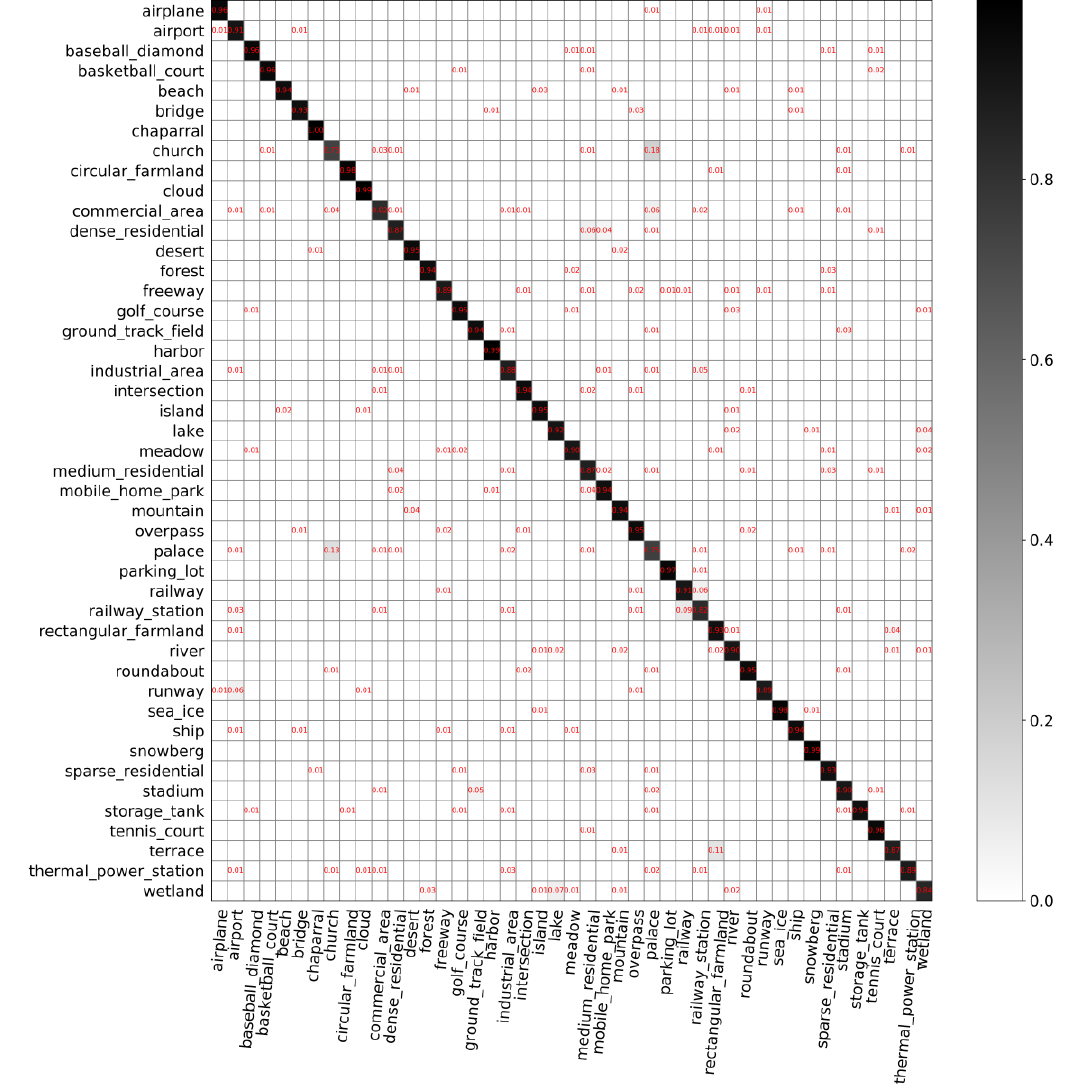
Figure 8. Confusion matrix on NWPU-RESISC45 with training set of 10% and validation set of